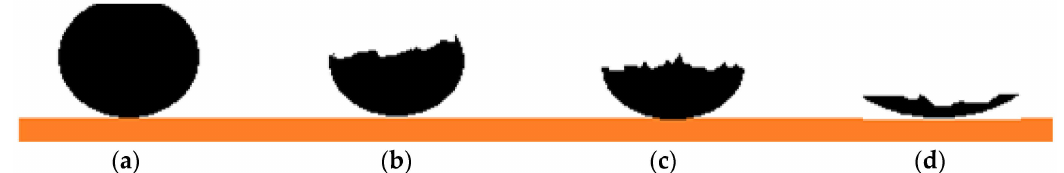
Figure 9. Plan and horizontal views of PTFE liquid marbles during evaporation: ( a ) initial liquid marble; ( b ) the marble begins to shrink as the shell wrinkles; ( c ) the outer shell is thikend and bulked; ( d ) liquid marble